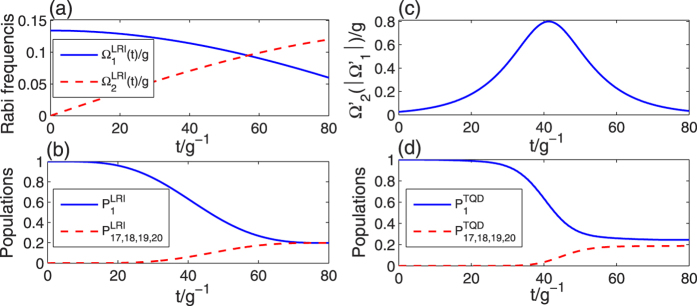
For the LRI method, (a) the time dependence of the Rabi frequencies Ω1(t) (blue solid line) and Ω2(t) (red dashed line); (b) the populations of states |ϕ1〉 and |ϕ17~20〉 governed by Htotal. For the TQD method, (c) the time dependence of the Rabi frequency 
; (d) the populations of states |ϕ1〉 and |ϕ17~20〉 governed by . The parameters used here are tf = 80/g, ε = 0.177, Δ = 6 g, τ = 0.14tf and T = 0.19tf.